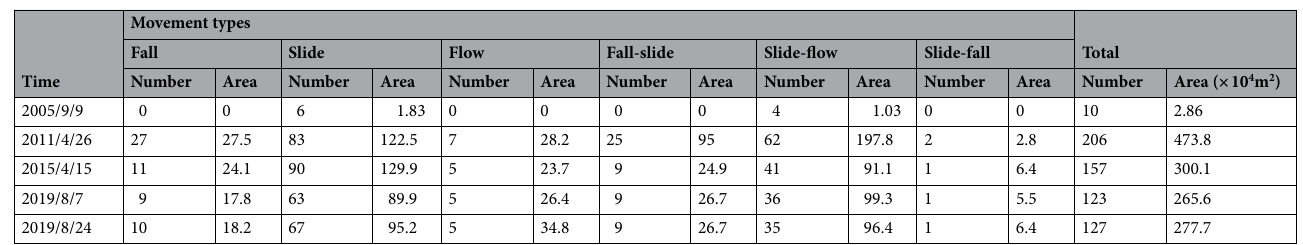
Table 4. Statistics of the source materials inventories before and after the